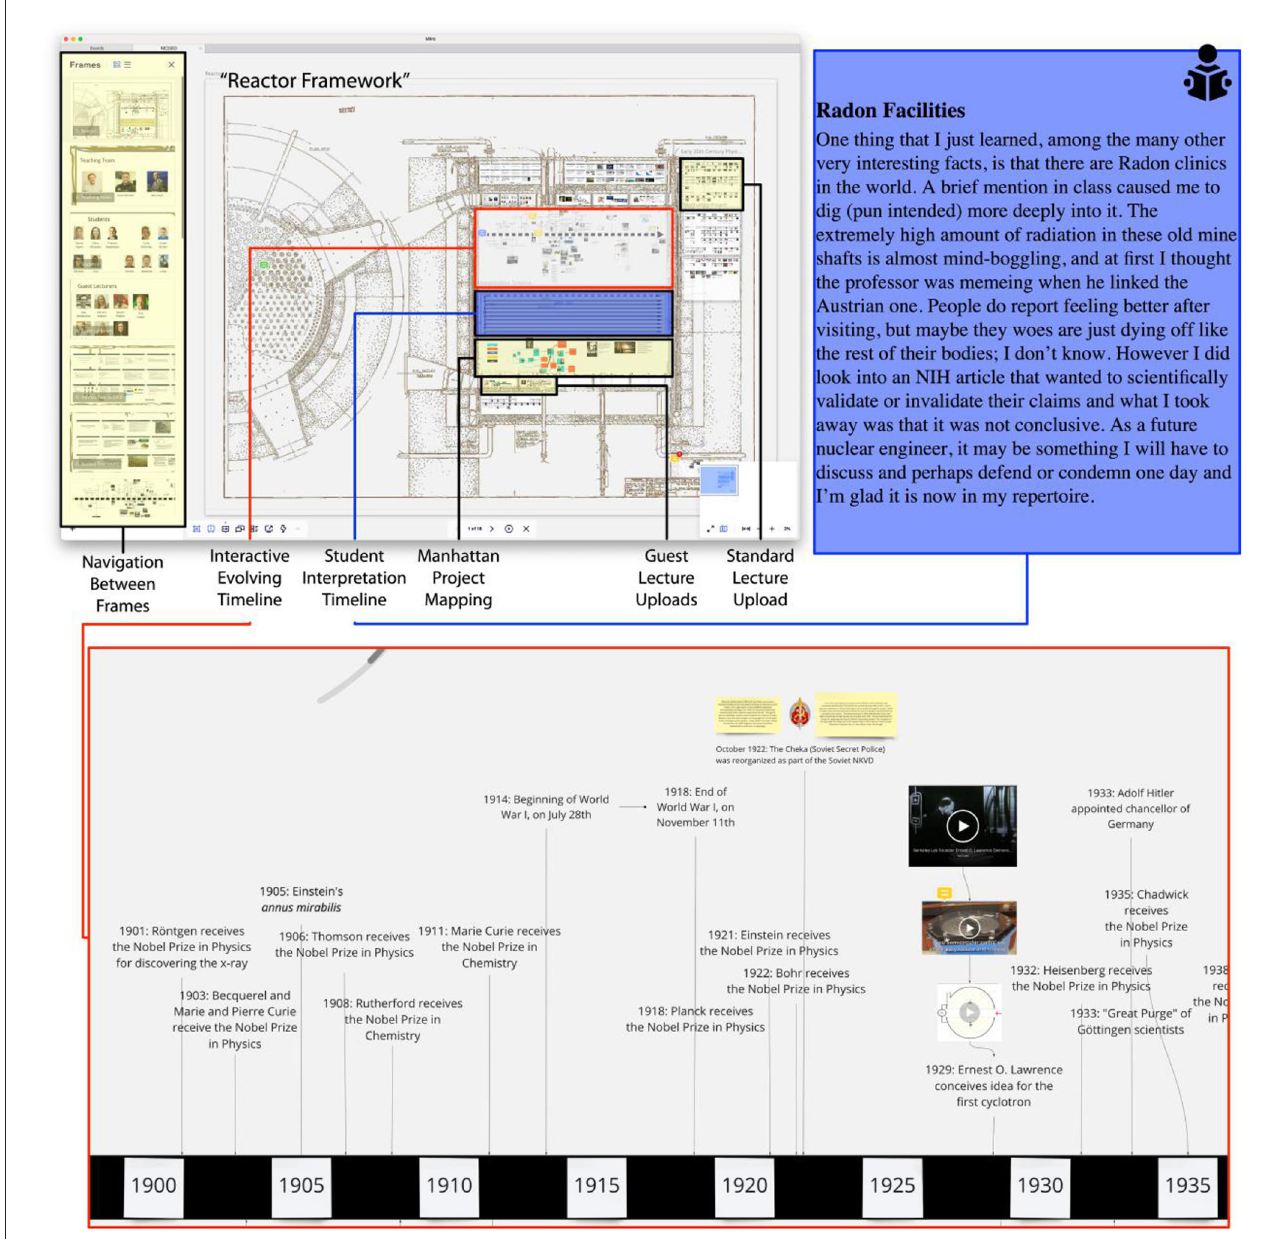
FIGURE18 Top left shows the complete MIRO board for NE290 and is annotated with specific features including the integrative evolving timeline, student interpretation timeline, and lecture slide integration. Top right in blue shows an example of a student response in regards to a lecture that discussed sociological issues concerning Radon contamination. Bottom shows an expanded timeline composed of milestones added by students throughout the course of